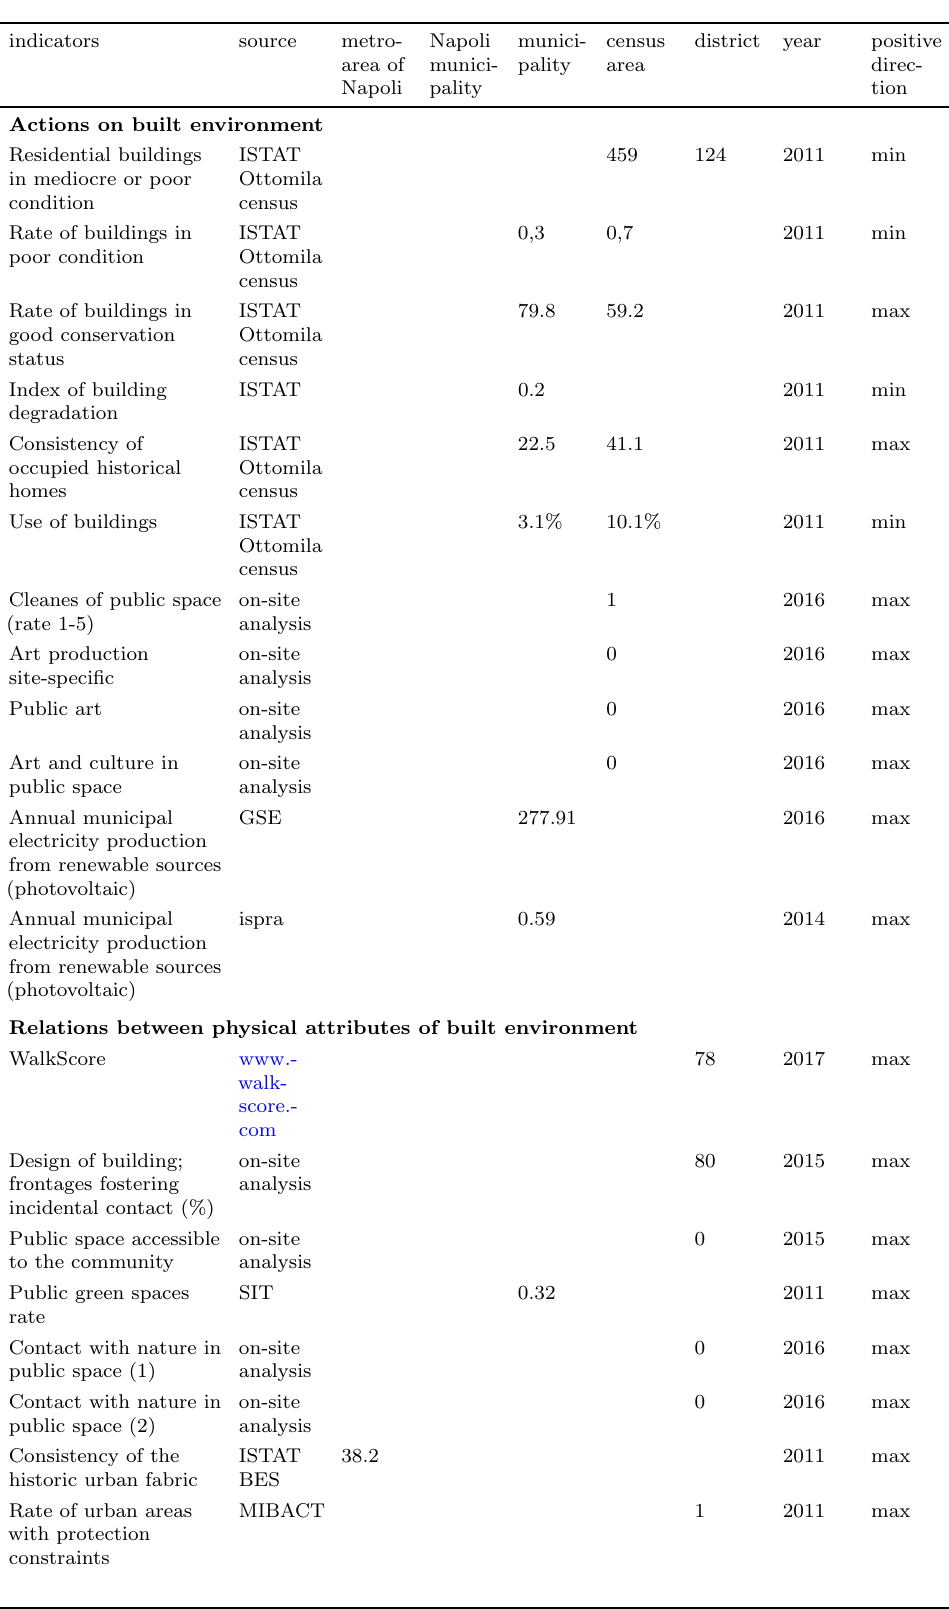
Table B.2: Existing relationships in Torre